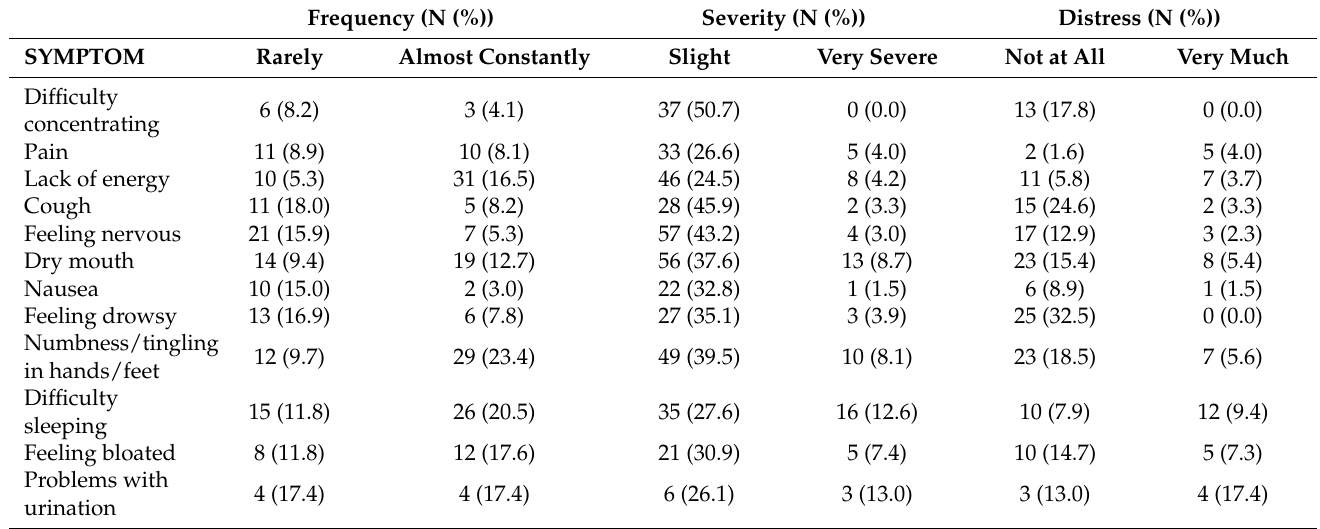
Table 3. Symptom descriptive of higher and lower frequency, severity and